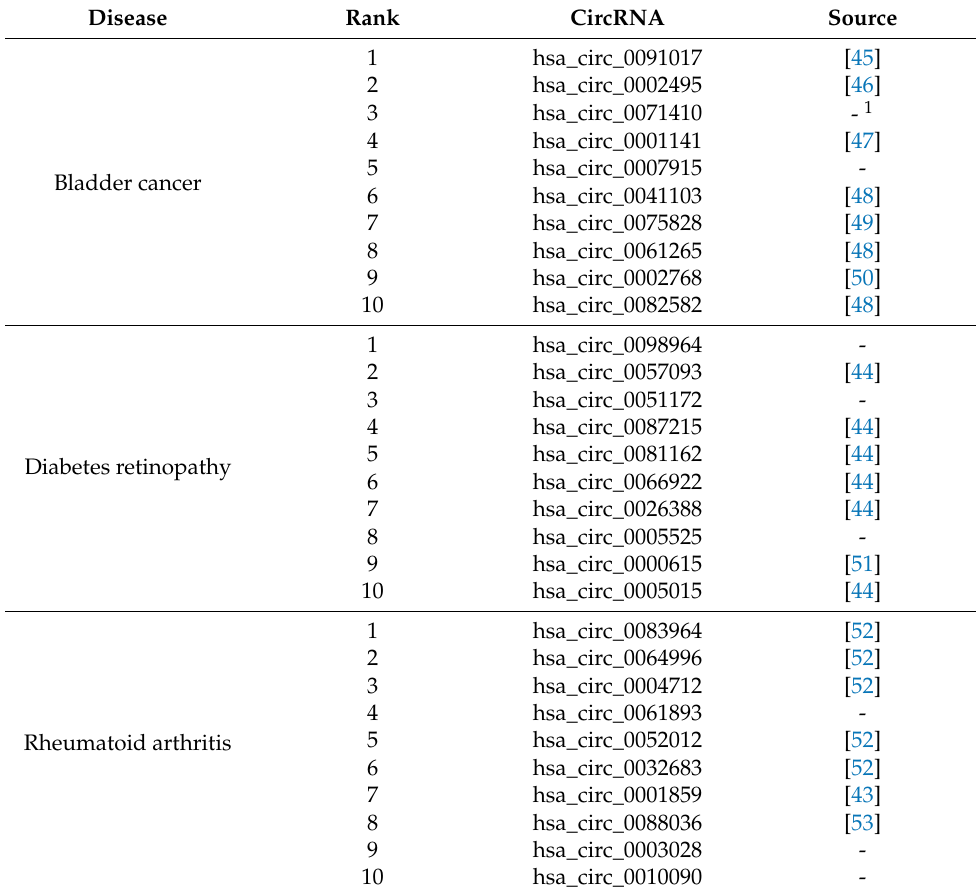
Table 1. Candidate circRNAs identified by GATCDA for bladder cancer, diabetes retinopathy and rheumatoid arthritis.